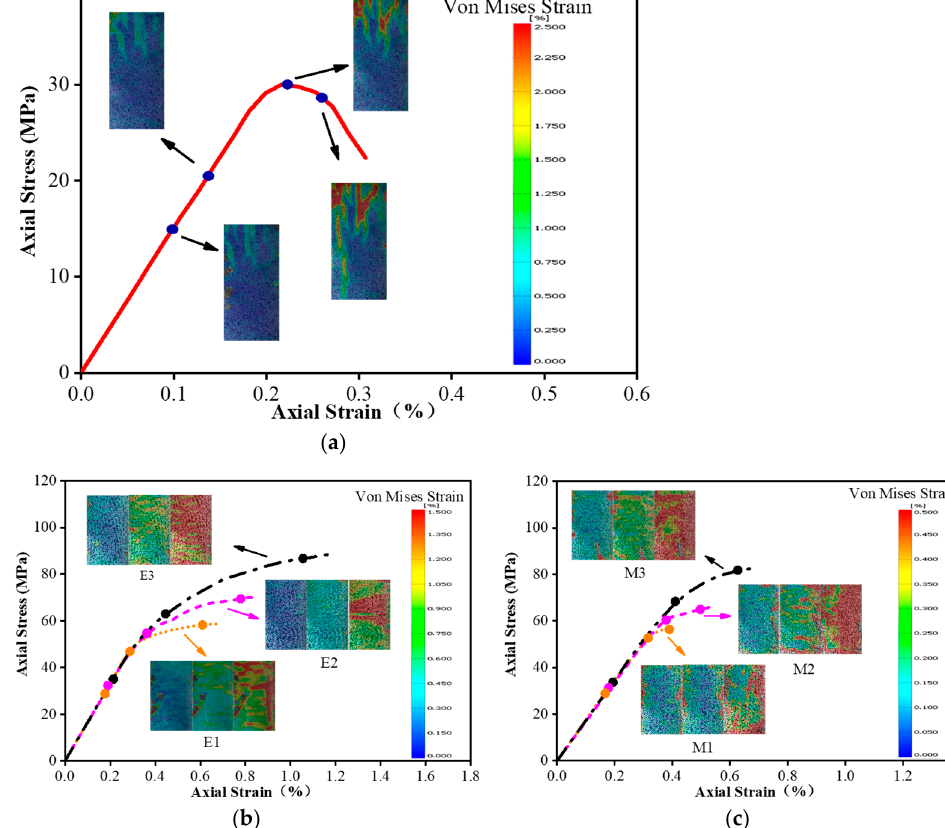
Figure 9. The Von Mises strain evolution of the ( a ) unconfined, ( b ) FRP ‐ confined, and ( c ) FRiP ‐ confined specimens obtained from the digital image correlation.